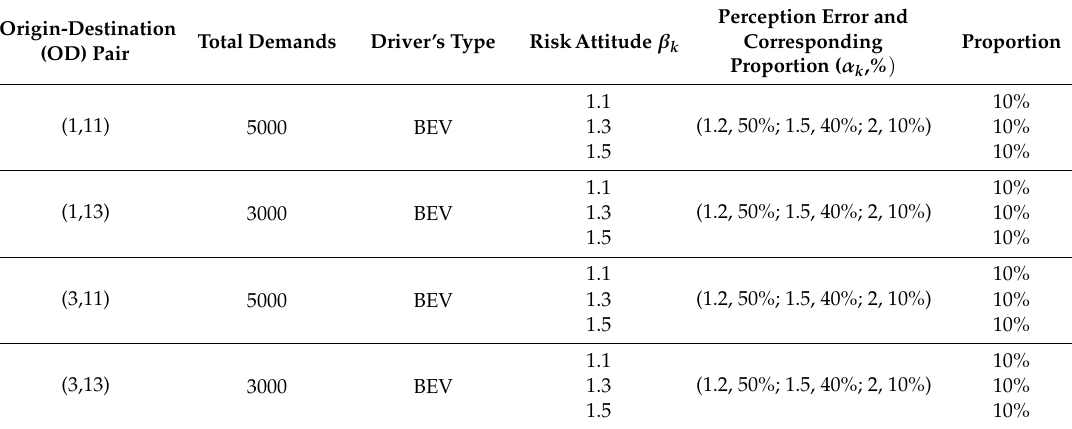
Table 2. The setting of parameters β k and α k